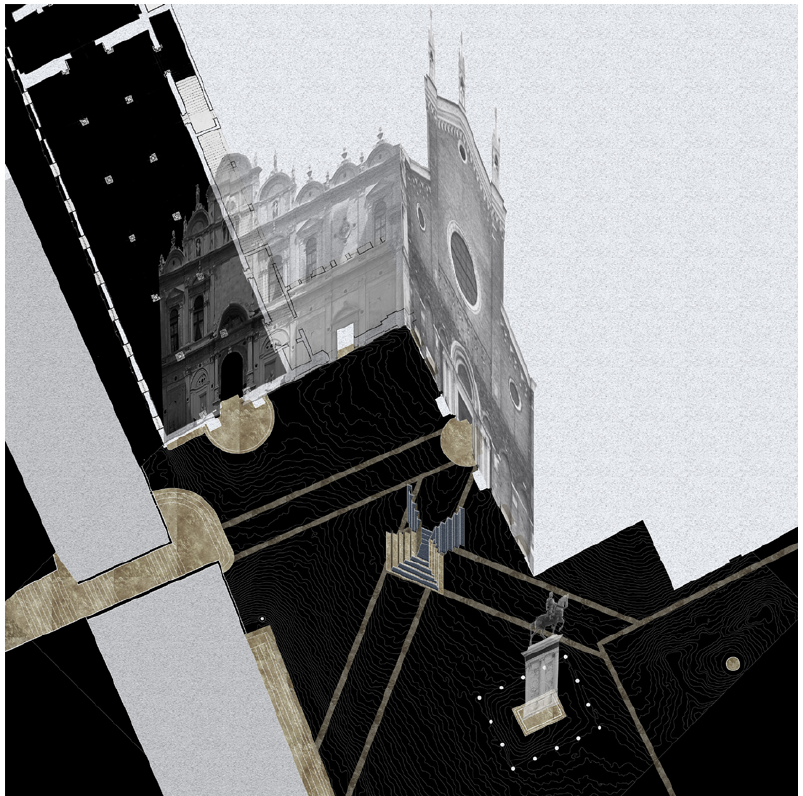
FIG. 8 Campo di San Giovanni e Paolo, axonometry with insertion of the quadruple module. Drawing and montage edited by the author, scale 1:200